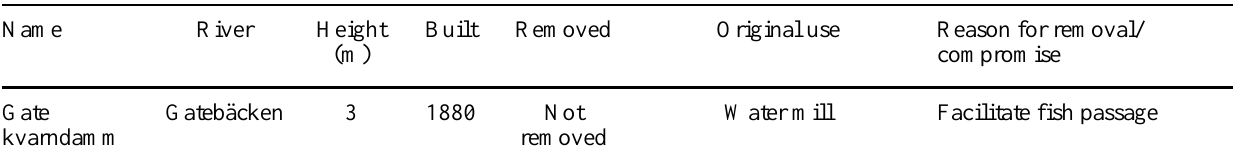
Table 1 . A list of Swedish dams and rivers subjected to/considered for restoration and the issues involved in the